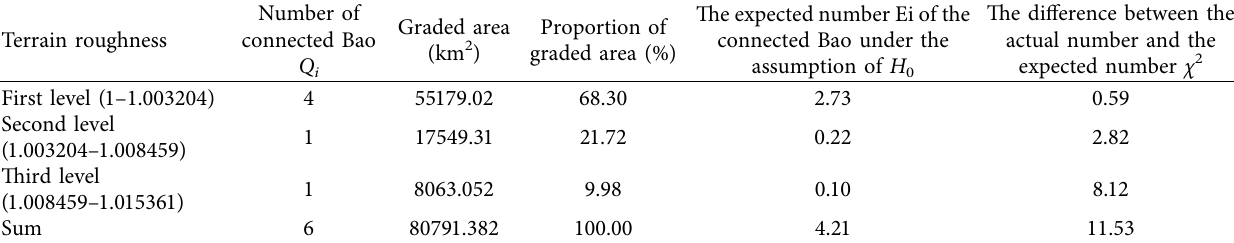
Table 3: Univariate chi-square test for terrain roughness.